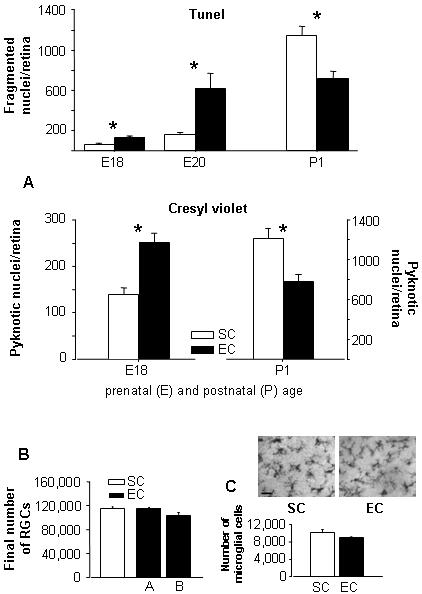
(A) Accelerated natural cell death in the RGC layer of EC rats.RGC layer apoptotic cell number in EC and SC rats, analyzed at the indicated ages with the Tunel method (top) and with cresyl violet staining of whole-mount retinas (bottom). With both methods, two-ways ANOVA showed an effect of age (p<0.001) and housing condition (p<0.05) and a significant age×housing condition interaction (p<0.001). Mann-Whitney rank sum test with Bonferroni correction revealed a difference between EC and SC at E18, E20 and P1 (p<0.001) for the tunel method, and at E18 and P1 (p = 0.002) for cresyl violet staining. (B) RGC number was not different between SC and EC adult rats either as estimated by calculating the 50% of total cell number in the RGC layer (A), or by subtracting the number of displaced amacrine cells remaining in the RGC layer 30 days after ipsilateral optic nerve transection from the number of cells counted in contralateral retinas (B) (p = 0.77 and 0.28, t-test). (C) Micrographs of RGC layer of P1 whole mount retinas labeled with B4 isolectin. No qualitative difference was detected in the shape and intensity of microglial cells between SC and EC pups. Scale bar: 20 µm. Graph: microglial cell number in the RGC layer of SC and EC rats. Mann-Whitney rank sum test showed no difference between the two groups (p = 0.429). Bars indicate s.e.m.